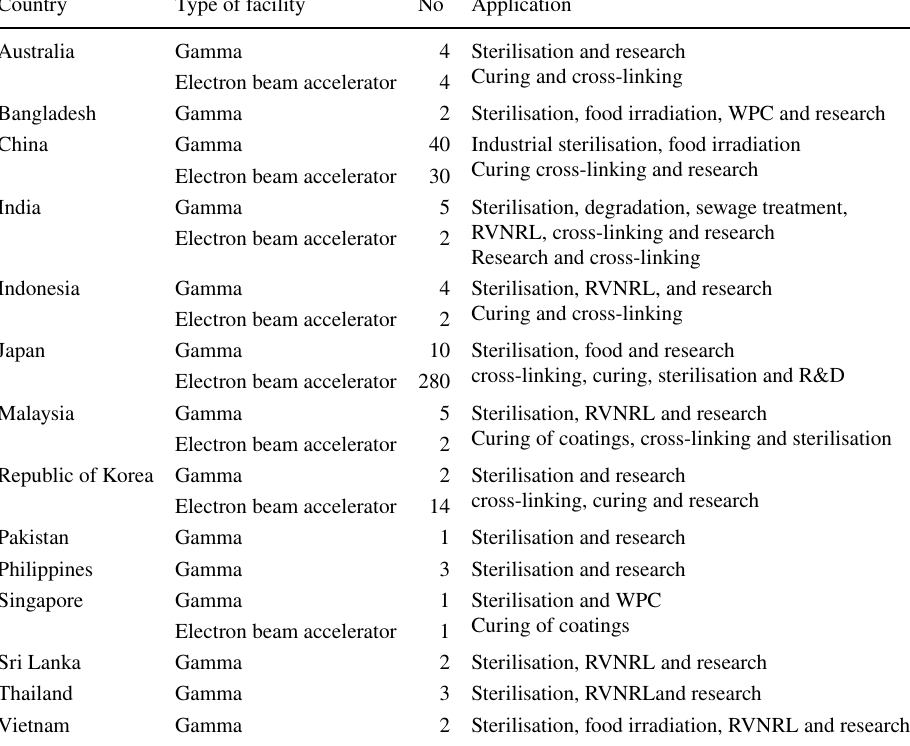
and its various applications at worldwide. Source: El-Motaium